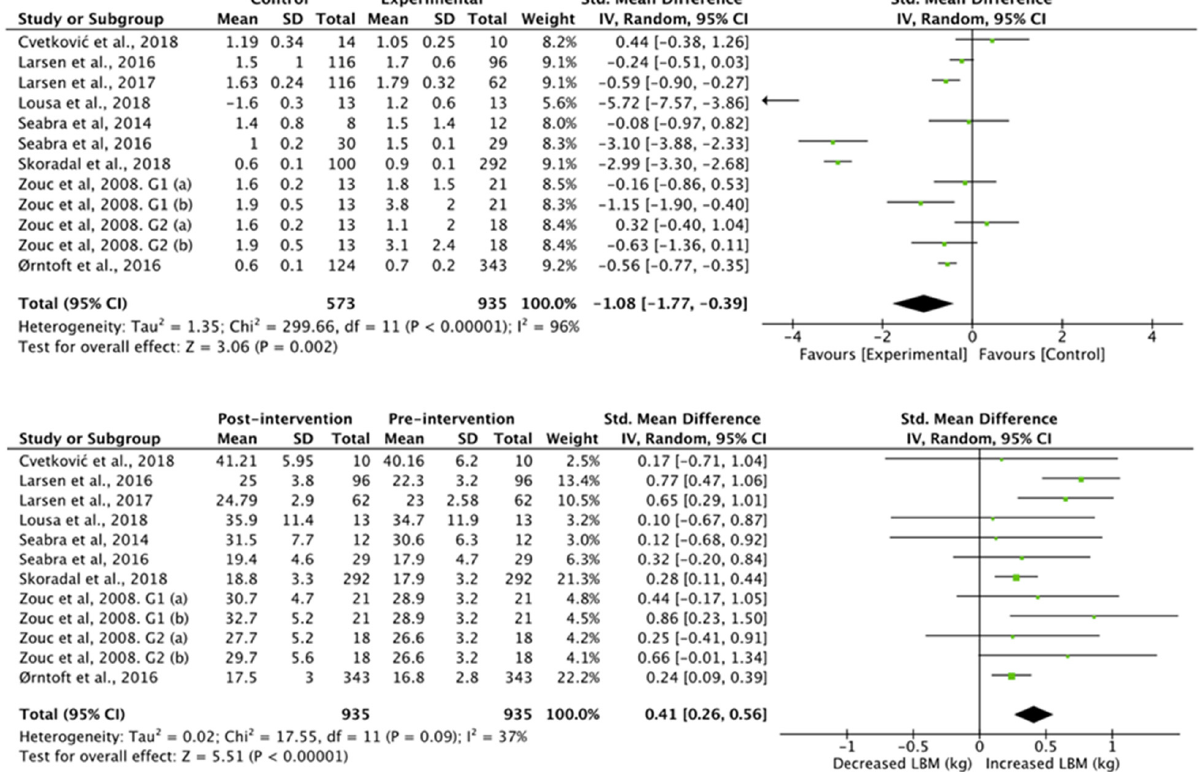
Figure 5. Results of a random effects meta-analysis for control group compared with experimental group and results post and pre intervention, shown as mean difference and standardized mean difference with 95% CIs for lean body mass [31–33,36–41].